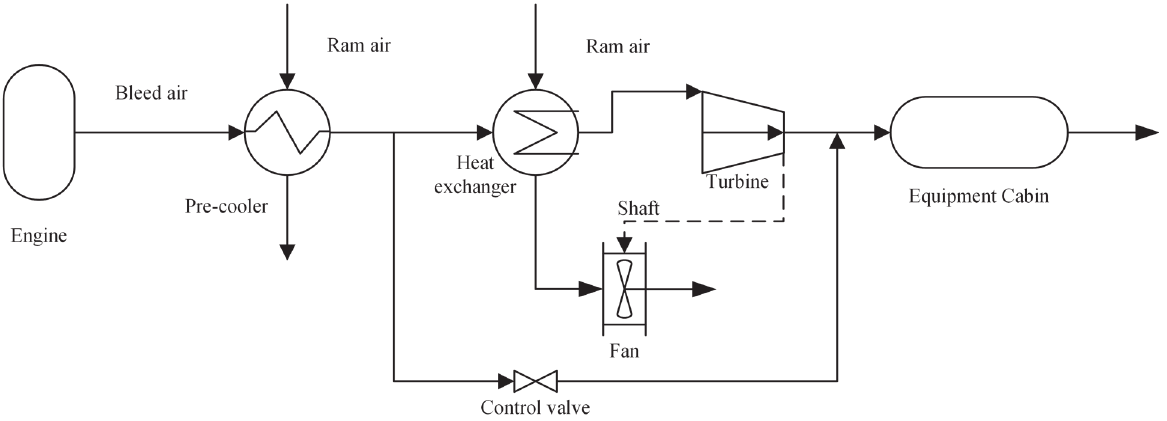
Fig 1. Structure of the chosen